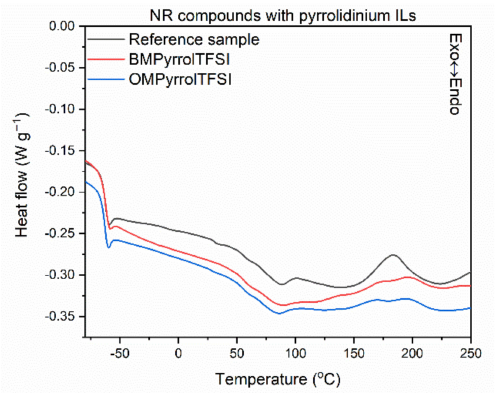
Figure 2. Differential scanning calorimetry (DSC) curves of NR compounds containing pyrrolidinium ILs with TFSI anion.